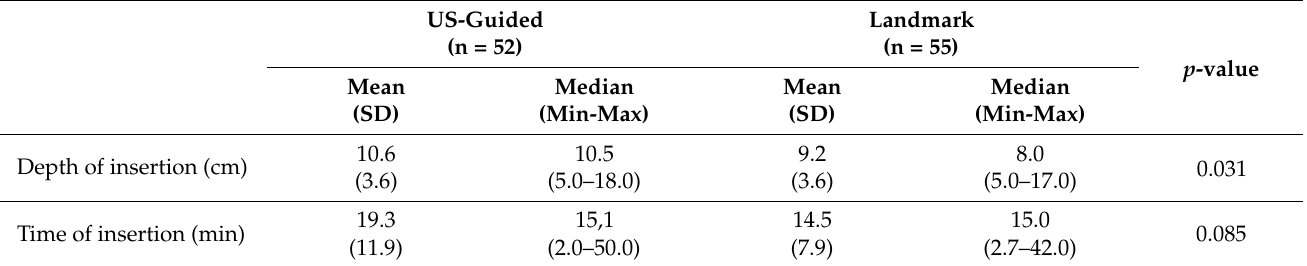
Table 4. Technical parameters of the